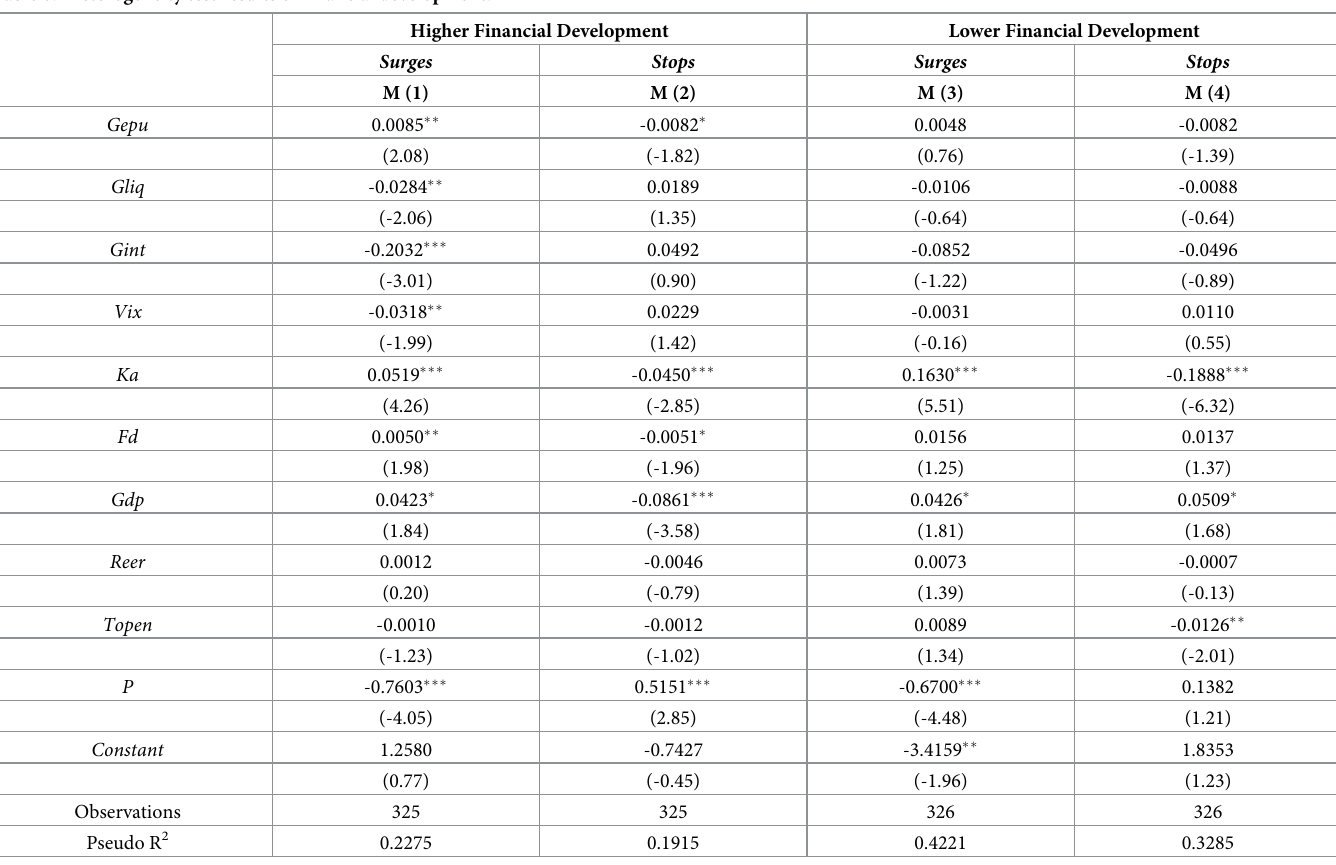
Table 6. Heterogeneity test results of financial